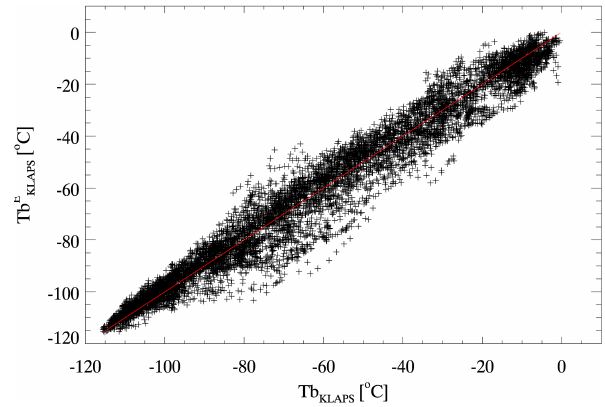
Figure 5. Scatter diagram for the estimated clear-sky Tb (Tb E obtained using the surface air temperature and water vapor pressure vs. the clear-sky Tb by the radiative transfer calculation (red line is the one-to-one line). The root mean square difference is 6.3K and the correlation coefficient is